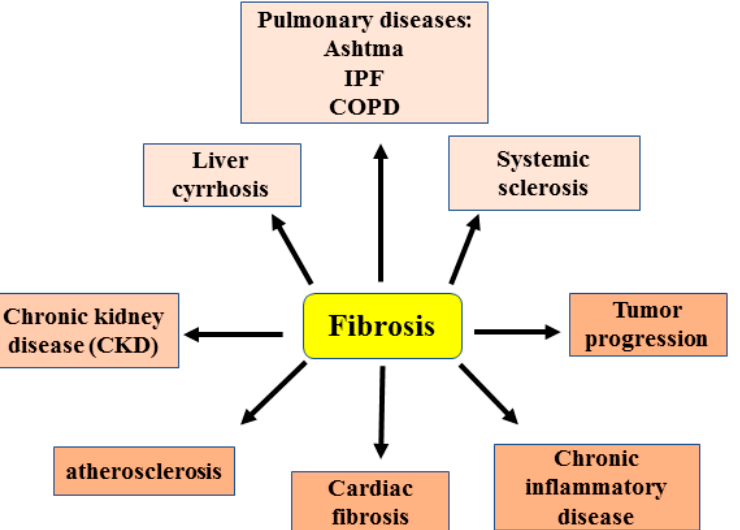
Figure 1. Schematic representation showing the involvement of fibrosis in several diseases (as explained in the text). IPF: idiopathic pulmonary fibrosis. COPD: chronic obstructive pulmonary disease.